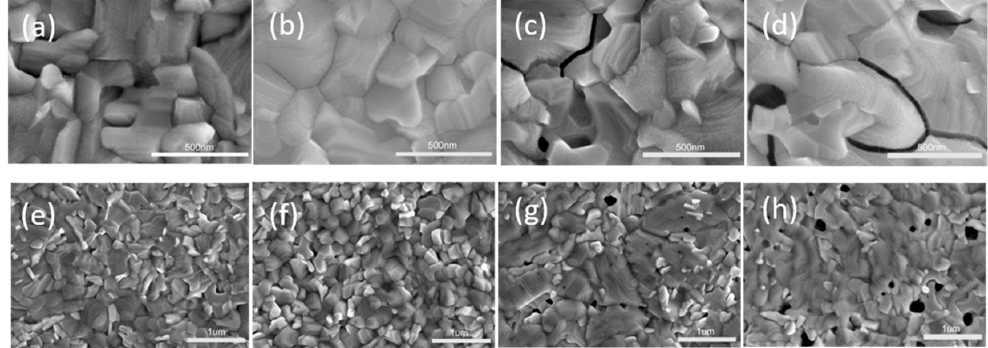
Figure 5. The SEM images of perovskite film by different precursors of 0DMF ( a , e ); 1DMF ( b , f ); 2DMF ( c , g ); 3DMF ( d , h ).